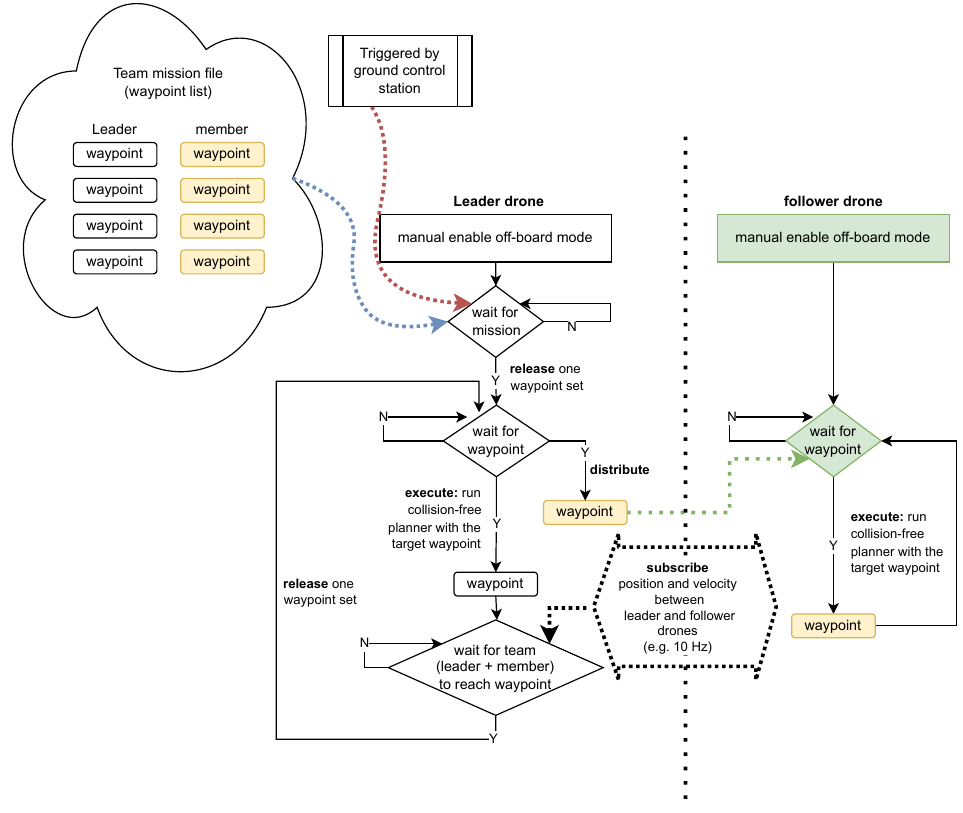
Figure 11. Protocol for formation